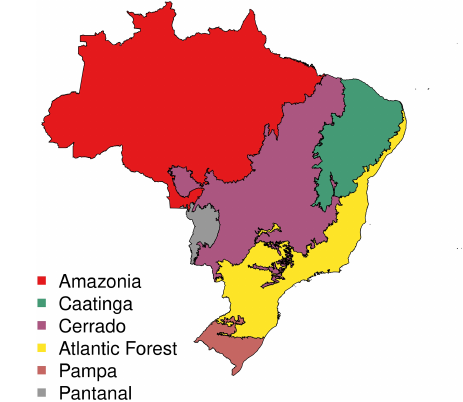
Figure 1. Map of the major biomes of Brazil. Amazonia and the Atlantic Forest contain largely moist tropical forest. In contrast, the Cerrado and Caatinga are hot and seasonally drought-affected sa- vannah ecosystems with substantial conversion to agriculture. The Pantanal is covered largely by wetlands. The Pantanal region has a temperate moist climate covered largely by grasslands and agri- culture. Map source: Brazilian Institute of Geography and Statis- tics (IBGE), Biomes and Coastal-Marine System of Brazil map, https://www.ibge.gov.br/, last access: 17 November